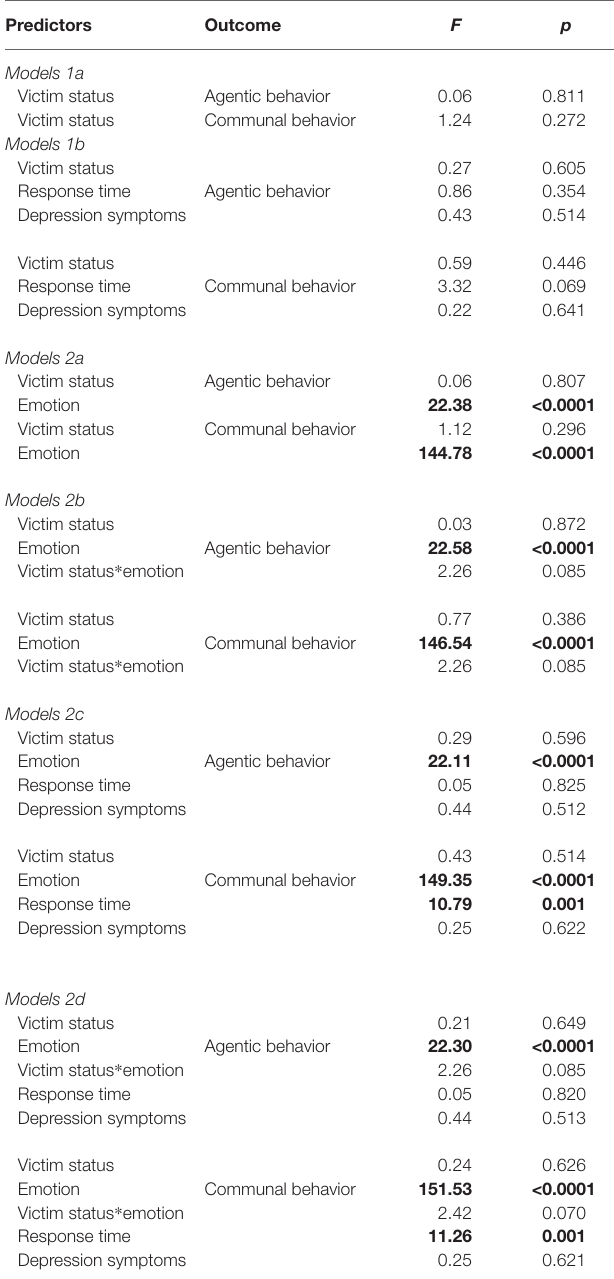
TABLE 5 | Associations between victimization status and agentic and communal behavior and moderation effects of type of emotion.